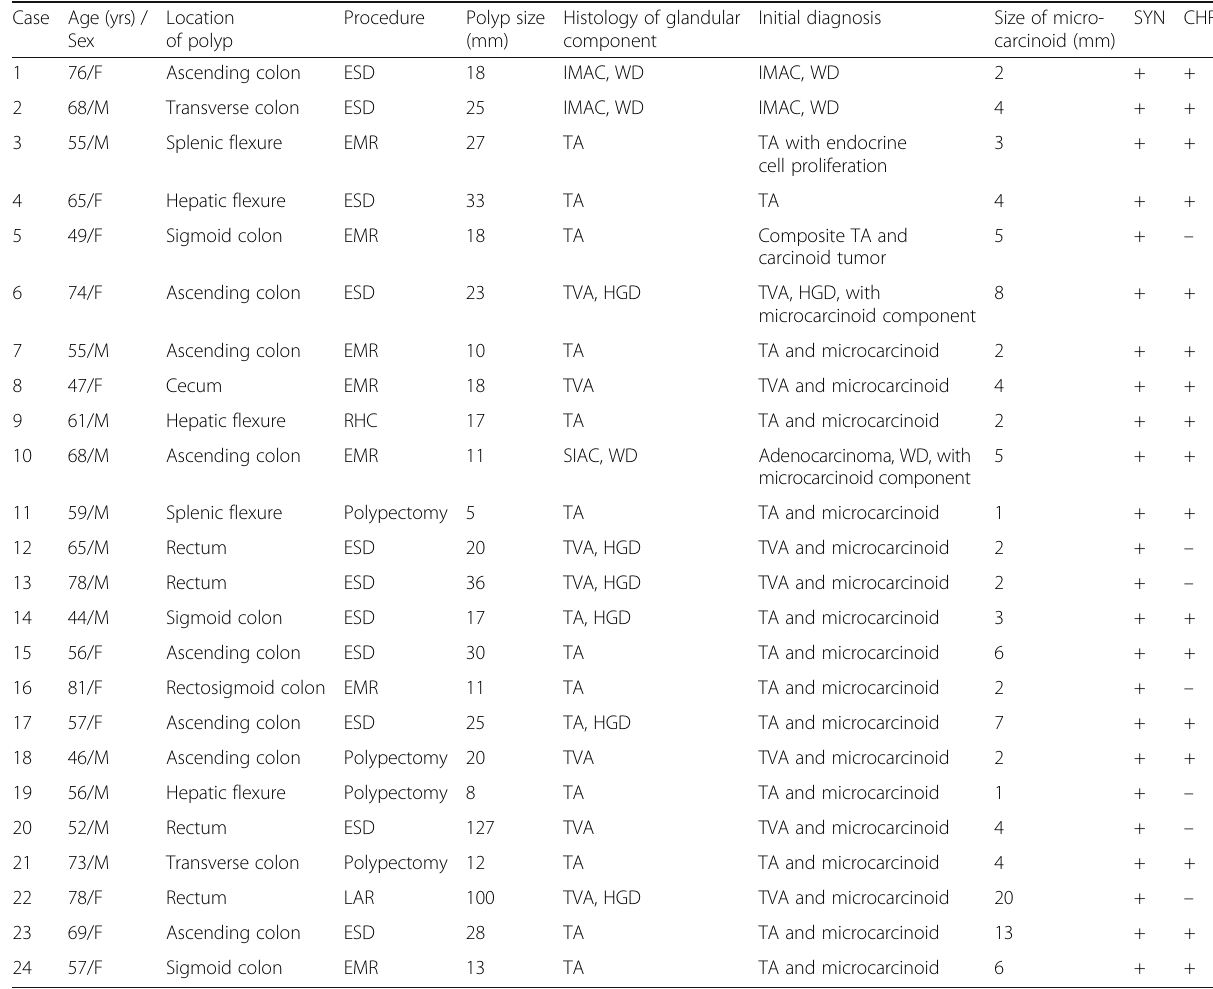
Table 1 Clinicopathologic features of the present study Case Age (yrs) /